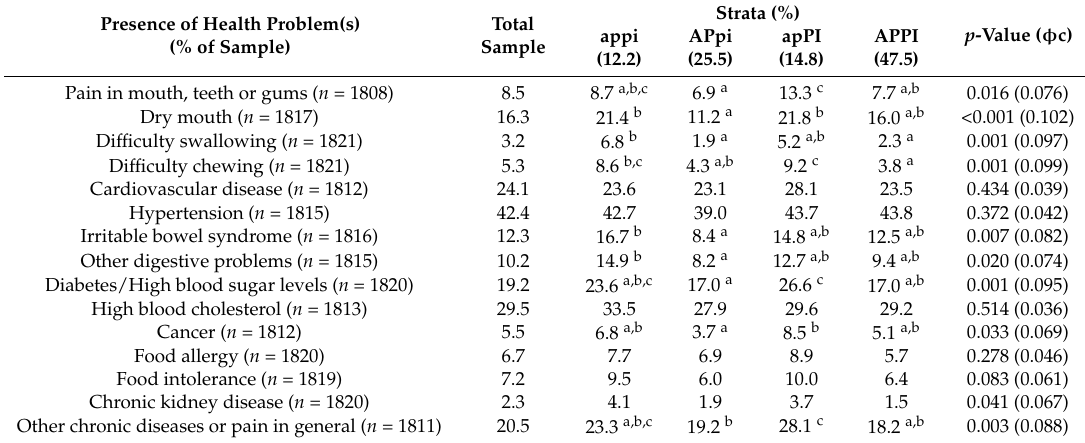
Table 4. Strata profiles based on health problems in 1825 adults aged 65 years and older from five European countries.